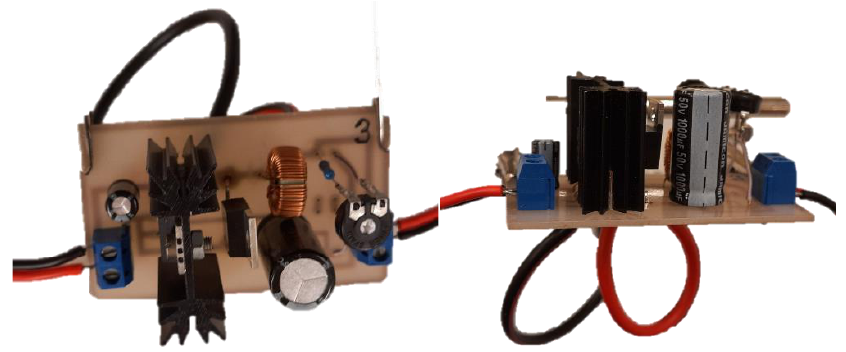
Figure 10. Real LM2576HV DC–DC converter—top ( left ) and side ( right ) view.